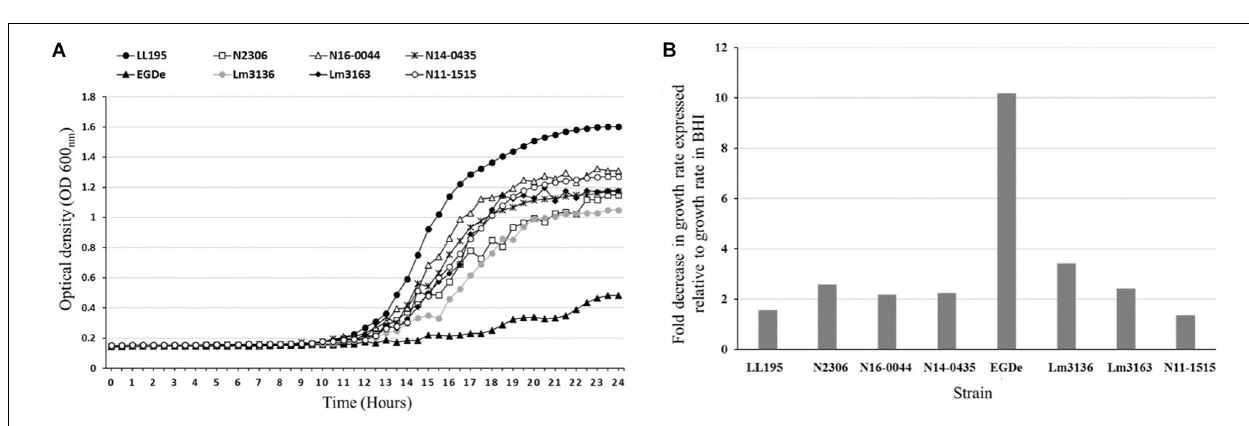
FIGURE 4 | NaCl stress tolerance variation among the L. monocytogenes strains. Growth curves (A) and bar charts (B) showing growth kinetics and fold decrease in growth rate of the L. monocytogenes strains during growth in BHI under NaCl salt (8%) stress. LL195 and EGDe strains showed the highest and lowest tolerance to NaCl salt stress, respectively. The data presented represents three independent biological